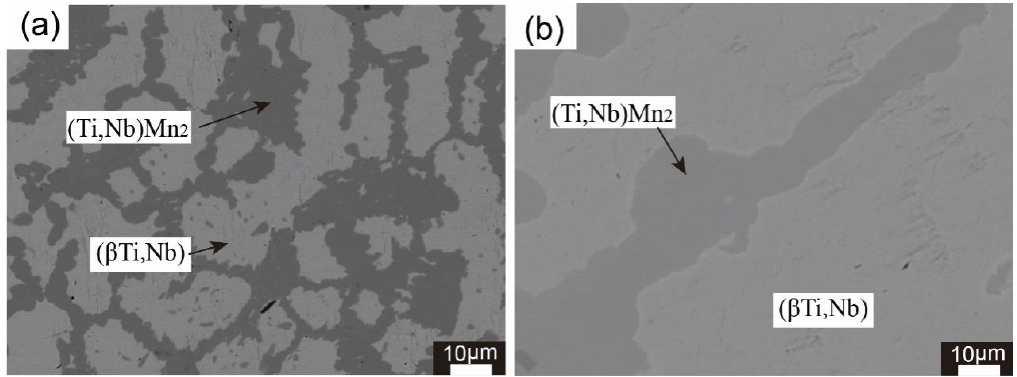
Figure 17. BSE images of alloys annealed at 1273K for 60 days: ( a ) B2, ( b ) B4.